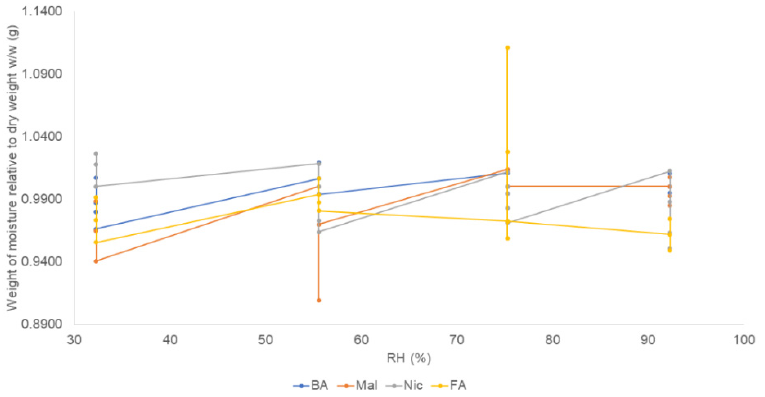
Figure 10. Short-term vapor sorption/desorption trends for bedaquiline salts exposed to increasing RH conditions of 32.8%, 57.6%, 75.3%, and 92.3%. After 21 days of exposure, the weights of moisture relative to dry weight were <2% w / w (g), suggesting that all salts’ weight changes remained below 0.02% w / w .